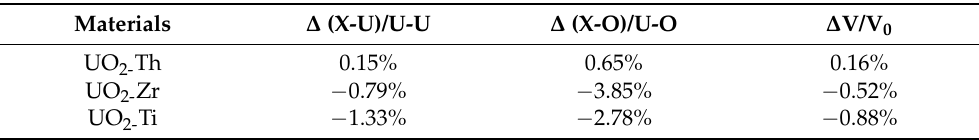
Table 4. Relative changes in lattice volume and bond length. X-U and X-O denote the distance between dopant and nearest uranium atom and oxygen atom, respectively. U-U denotes the distance between uranium atoms, U-O represents the distance between uranium atom and oxygen atom, and ∆ (X-U) and ∆ (X-O) is the absolute change in bond length. Absolute variation of complete UO volume (V 0 ) and doped UO 2 volume ( ∆